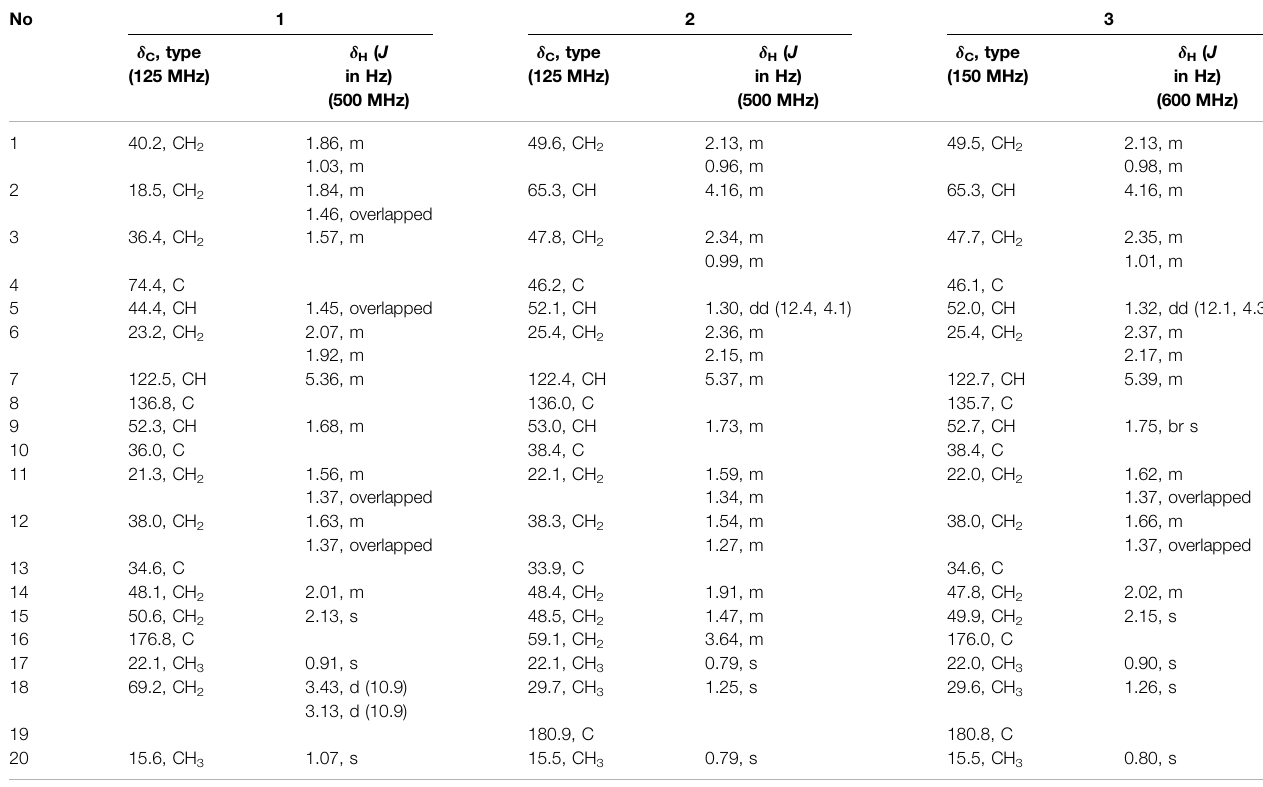
TABLE 1 | 1 H NMR and 13 C NMR spectroscopic data for 1 – 3 (Methanol- d 4